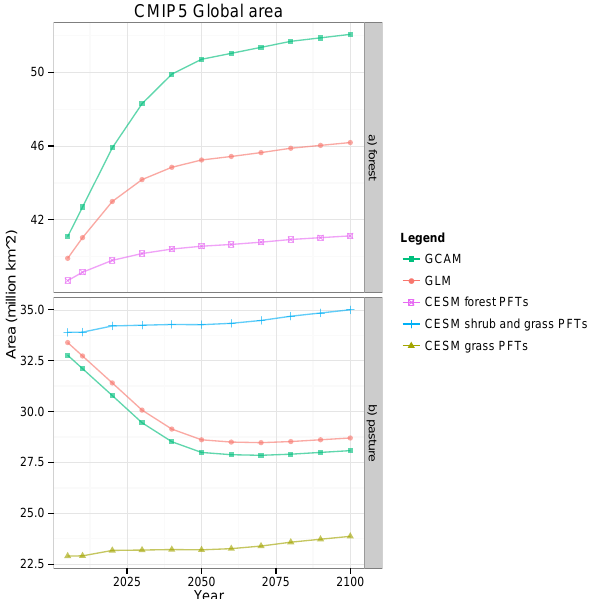
Figure 6. iESM land use and forest area changes with respect to 2015. The GLM-NEWLUT forest and pasture data are nearly iden- tical to the GLM-OLDLUT data and are not shown for clarity. Sim- ilarly, the GLM-NEWLUT cropland data are nearly identical to the GCAM-NEWLUT